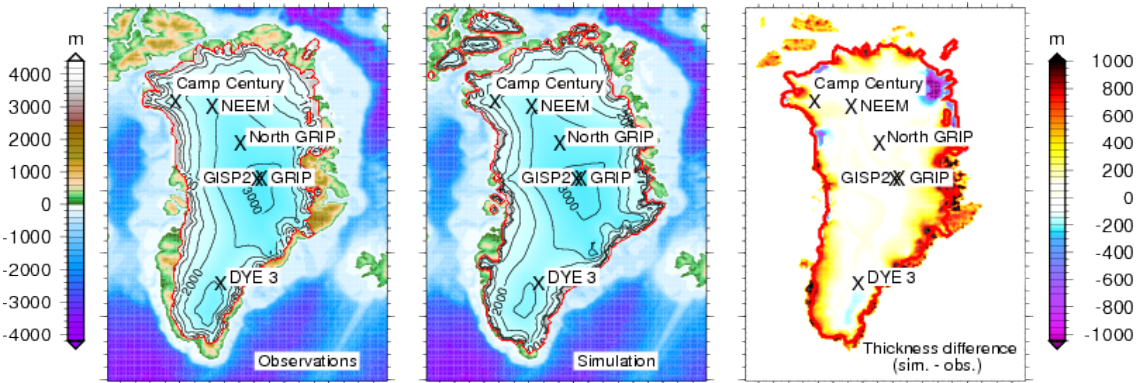
Fig. 4. Present-day GIS geometry in the observations (Bamber et al., 2001) and simulated after a transient run with free surface evolution and with calibrated parameters. Ice thickness differences between simulation and observation are represented. Deep ice cores are located on the map. Contour spacing is 500m. The ice sheet margin is represented by the red contour. The simulated present-day ice sheet is generally too thick at the margins except in the northeastern region. The bedrock is far below sea level in this area, and the current ISM does not maintain this fjord glaciated. After calibration, the resulting simulated ice sheet presents a +0.8m of sea level equivalent compared with observations.